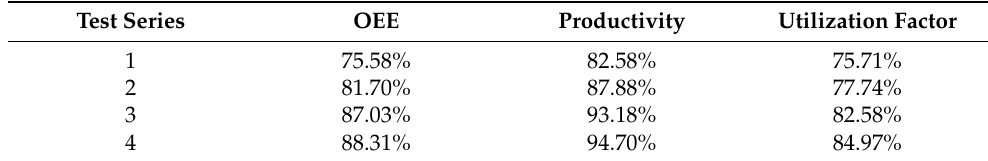
Table 2. Target values of the test series.